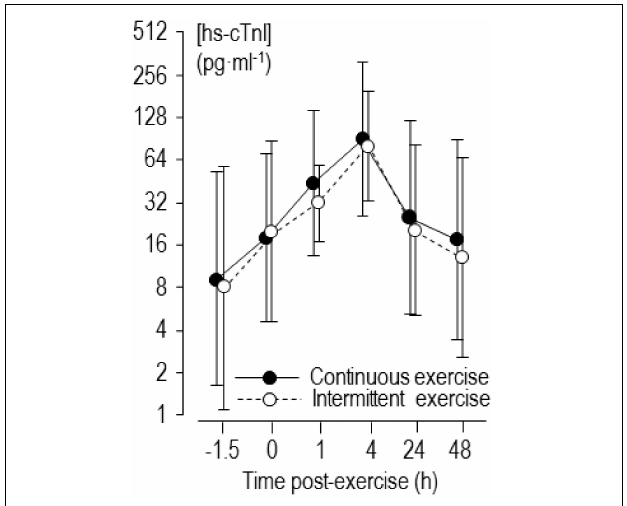
FIGURE 1 | Back-transformed means of log-transformed concentrations of high-sensitivity cardiac troponin I (hs-cTnI) 1.5 h before and 0–48 h after continuous and intermittent exercise. Error bars are standard deviations.